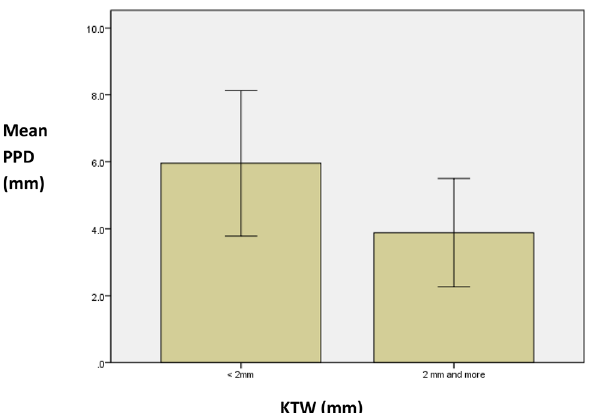
Figure 1. Mean of periodontal pocket depth (PPD) in mm based on keratinized tissue width (KTW) around